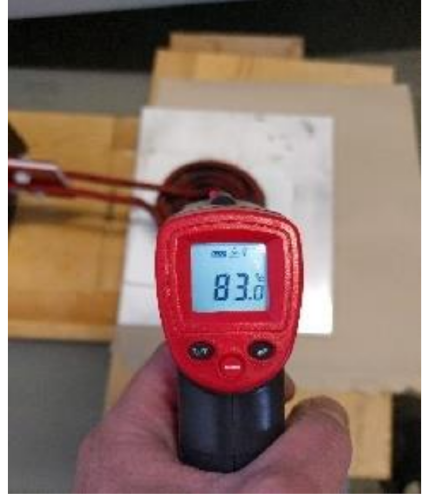
Figure 9. Temperature reading of the induction